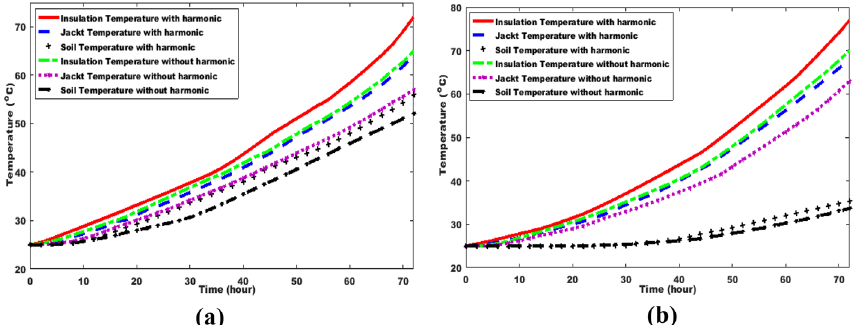
Fig. 10 Comparison of dynamic temperature obtained from experimental measurements a with linear and nonlinear loads at direct buried, b with linear and nonlinear loads at installed inside PVC duct in the